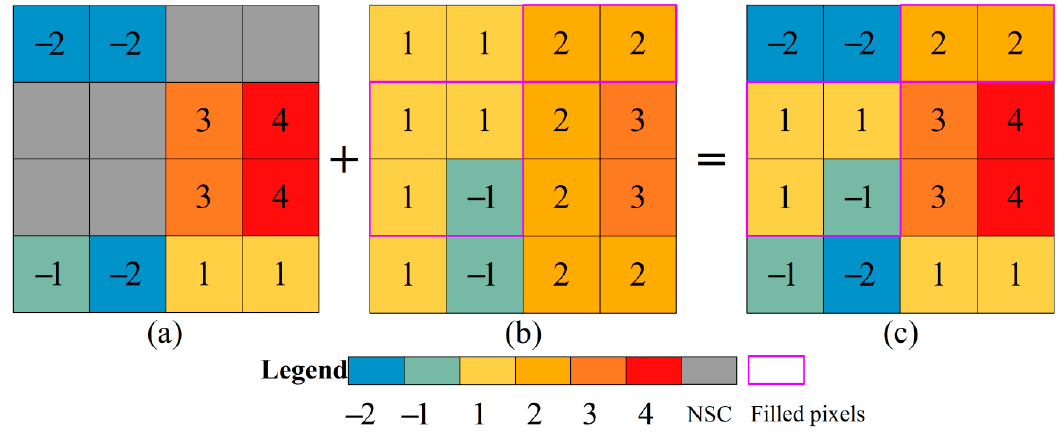
Figure 4. Combination of TSS-RESTREND and RESTREND in ArcGIS: ( a ) indicates the TSS-RESTREND result, ( b ) indicates the RESTREND result, and ( c ) indicates the combination result of TSS-RESTREND and RESTREND; NSC indicates no significant change pixels. Filled pixels indicate the significant change pixels in RESTREND used to fill the hole caused by the pixels with an insignificant change in TSS-RESTREND.